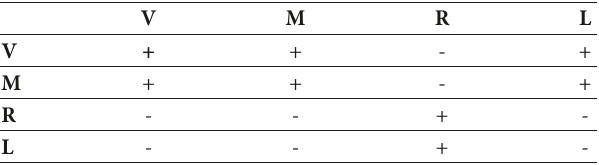
Table 2: The relative sign of a hedge in a row with respect to a hedge in a